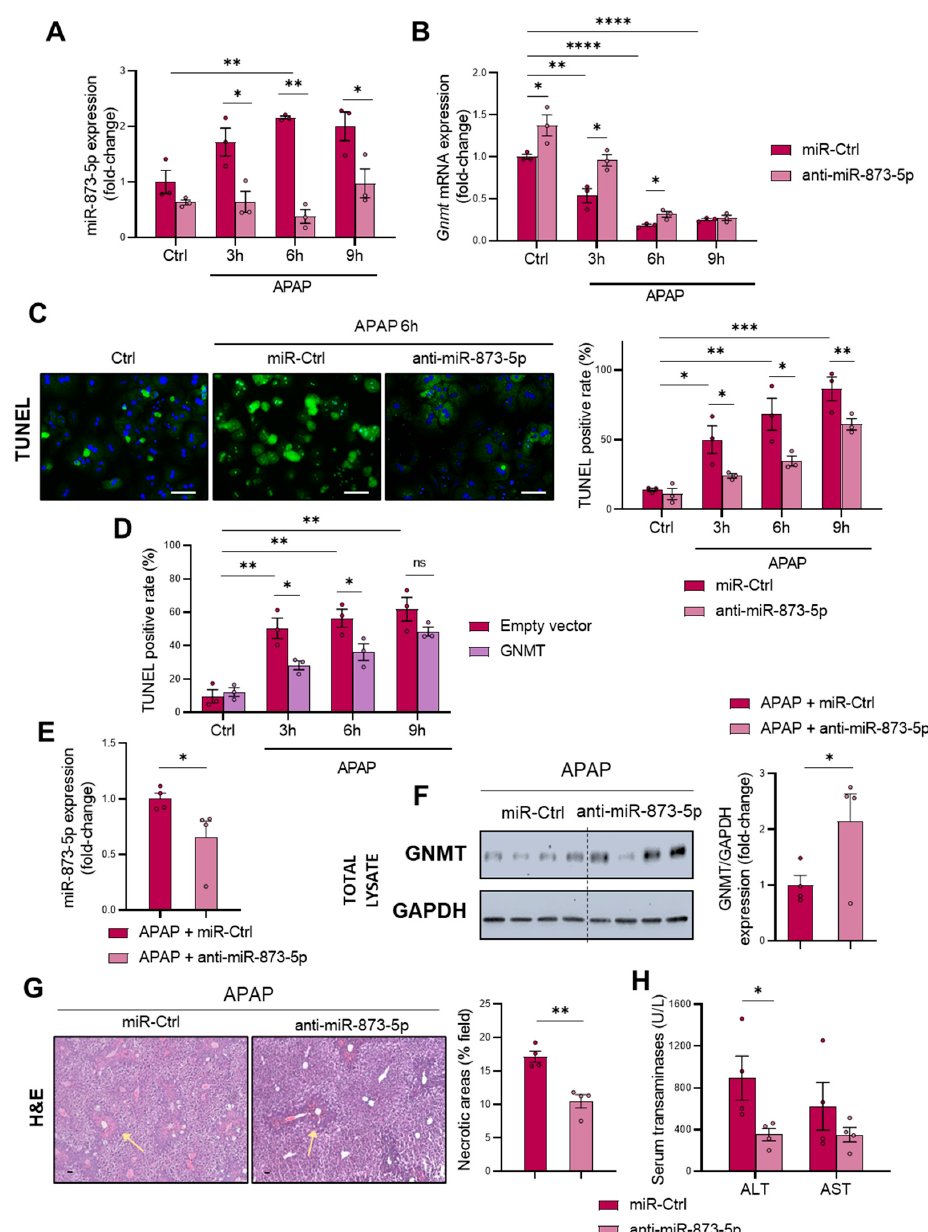
Figure 3. Targeting miR-873-5p restores glycine-N-methyltransferase (GNMT) expression protecting hepatocytes from DILI ( A ) miR-873-5p and ( B ) Gnmt expression and ( C ) representative micrographs and respective quantification of TUNEL staining in primary hepatocytes after 3, 6 and 9 h of 10 mM acetaminophen (APAP) stimulation and treated with an anti-miR against miR-873-5p (anti-miR-873-5p) or an unrelated control (miR-Ctrl); ( D ) TUNEL determination in primary hepatocytes stimulated with 3, 6 and 9 h APAP and treated with a GNMT expression or an empty vector; ( E ) Hepatic miR-873-5p and ( F ) Western blot determination of GNMT and respective determination related to a loading control, ( G ) representative micrographs of hematoxylin and eosin (H&E) staining and respective quantification of necrotic areas (highlighted with yellow arrows), and ( H ) serum transaminases levels (alanine aminotransferase (ALT) and aspartate aminotransferase (AST) from mice administered 360 mg/kg APAP for 48 h and treated with either anti-miR-873-5p or miR-Ctrl. Scale bar corresponds to 50 μ m. * p < 0.05, ** p < 0.01; *** p < 0.001 and **** p < 0.0001 are shown. (See also Supplementary Figures S1–S3).